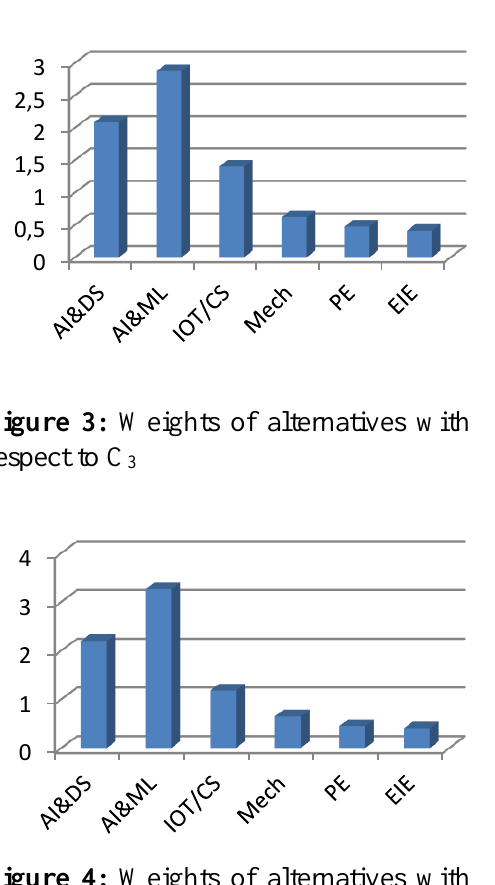
Figure 4: Weights of alternatives with respect to C 4